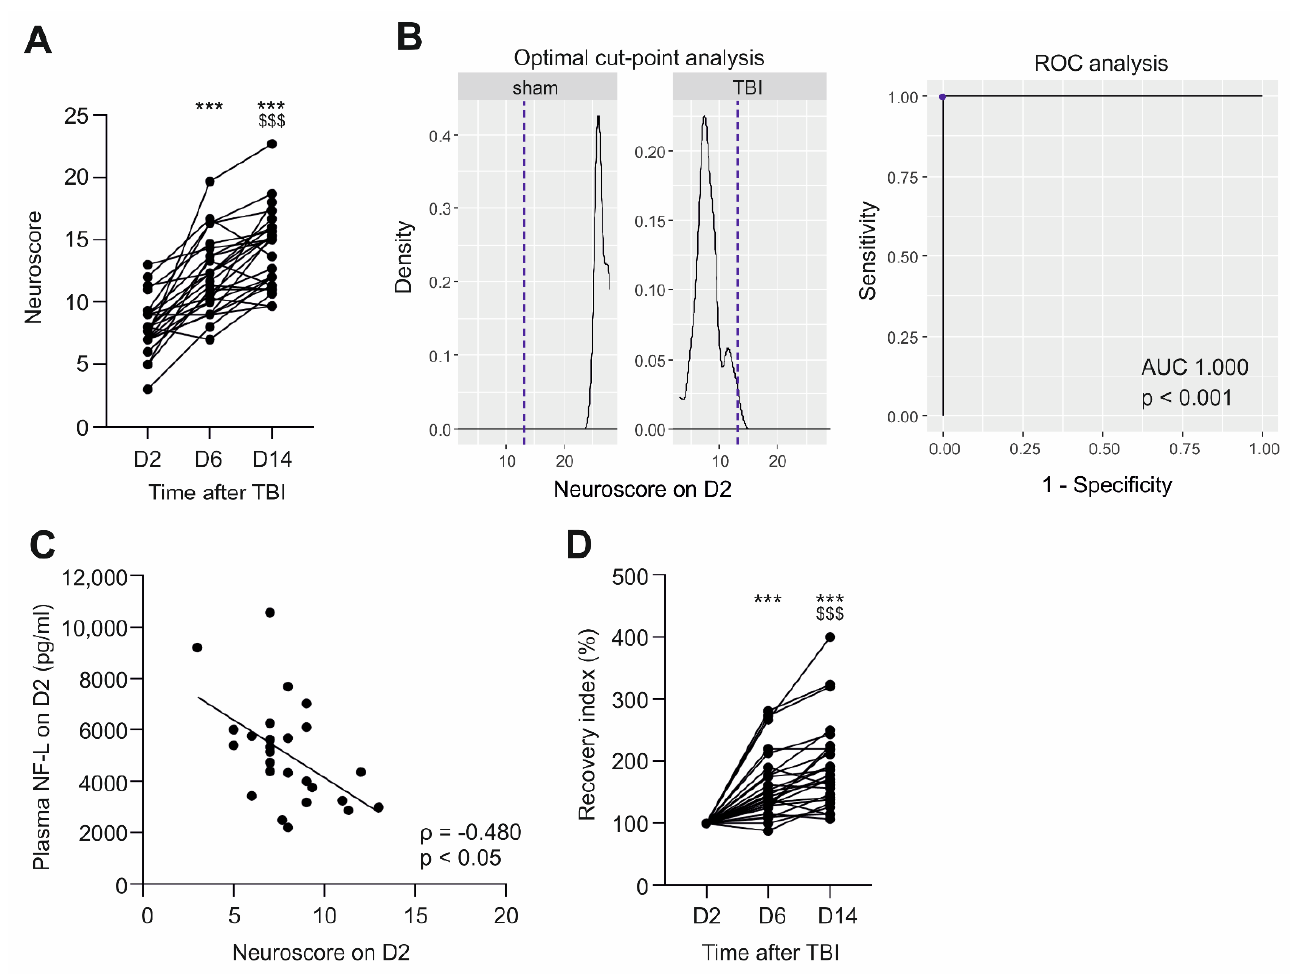
Figure 4. Plasma NF-L and somatomotor performance after TBI. ( A ) Evolution of the neuroscore in each TBI rat (n = 26) over the 14-day follow-up (D2, D6, and D14) after TBI. Note that in the sham- group, the average neuroscore was 26.5 on D2, 27.4 on D6, and 27.5 on D14. ( B ) The optimal cut-off and ROC analysis indicated that the D2 neuroscore differentiated TBI (n = 26) and sham-operated rats (n = 8) with 100% sensitivity and 100% specificity [AUC 1.0, p < 0.001, cut-off 13.0 (dashed line)]. ( C ) Spearman’s correlation revealed that the higher the plasma NF-L levels on D2, the lower the neuroscore on D2 post-TBI ( ρ = − 0.480, p < 0.05). ( D ) Improvement of the neuroscore (recovery index) for each TBI rat (n = 26), compared with the neuroscore on D2. Statistical significances: ***, p < 0.001 compared to D2; $$$, p < 0.001 compared to D6 (Wilcoxon matched pairs signed rank test). Abbreviations: AUC, area under the curve; D2, day 2 post-TBI; D6, day 6, D14, day 14; NF-L, neurofilament light chain; ROC, receiver operating characteristics; TBI, traumatic brain injury.